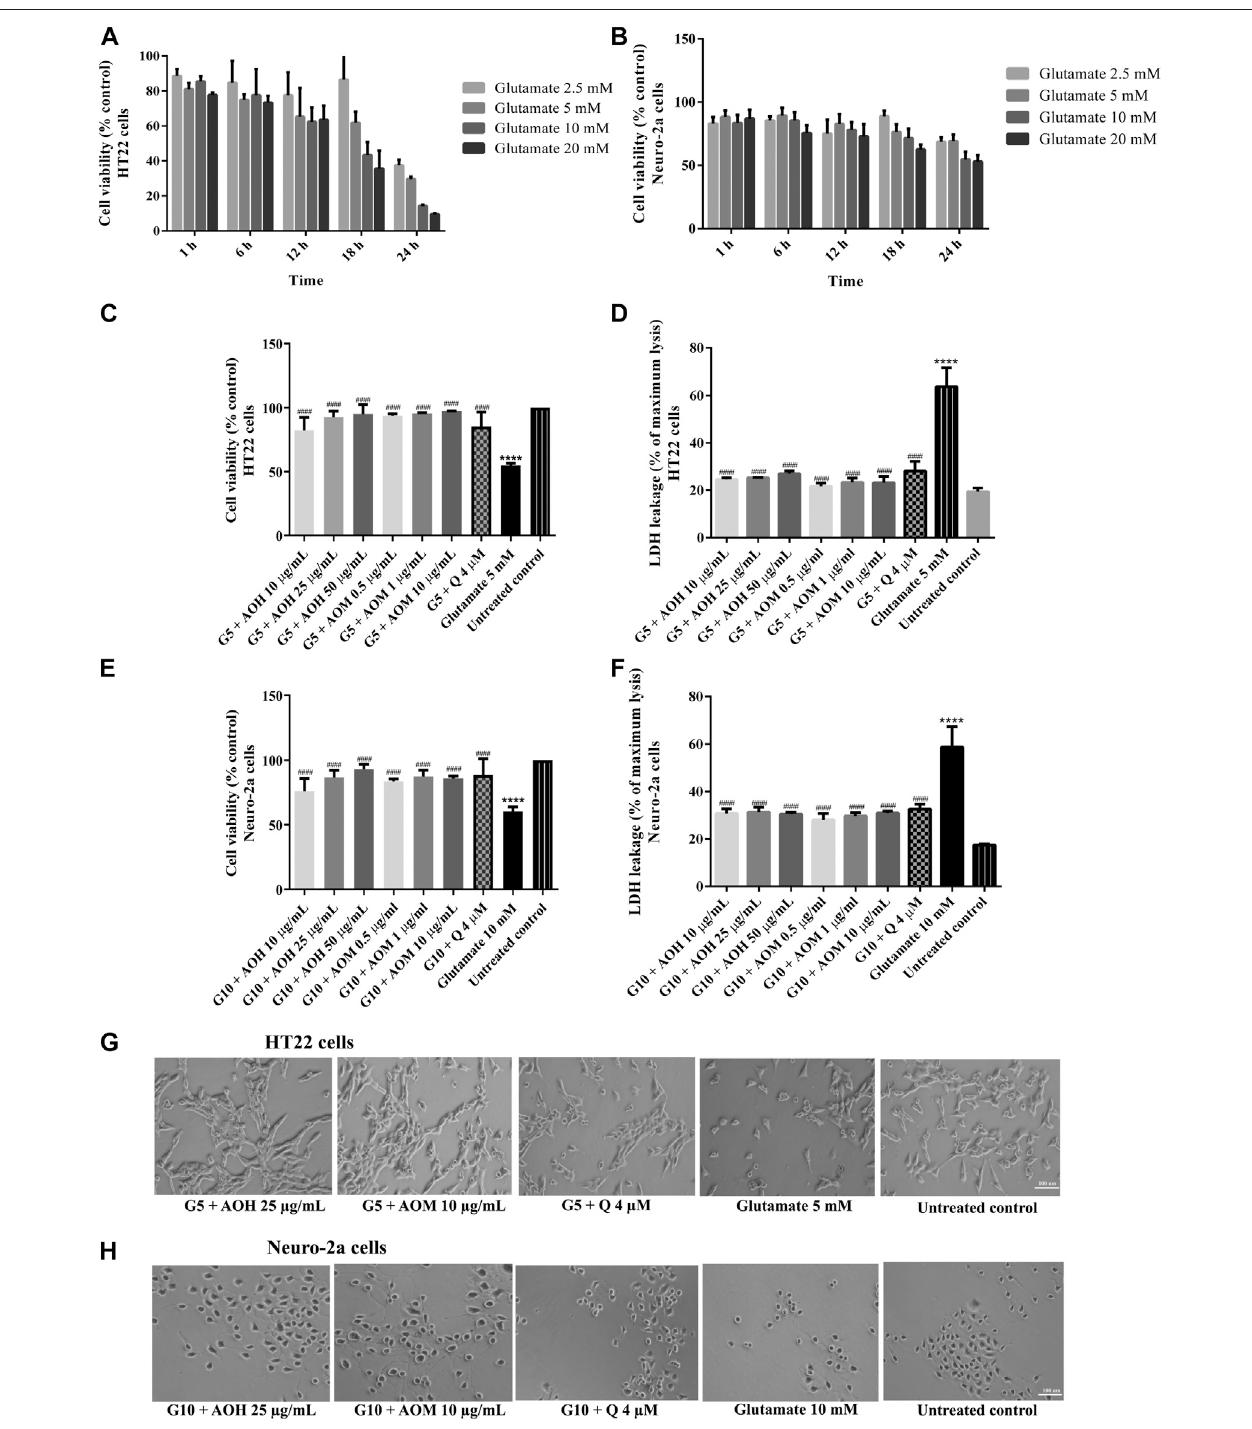
FIGURE4| ProtectiveeffectsofAOextractsonglutamate-inducedtoxicityinHT22andNeuro-2acells.Cellswereexposedtovariousconcentrationsofglutamate for different times in HT22 (A) and Neuro-2a cells, cell viability was measured by MTT assay (B) . Cell viability of HT22 (C,D) and Neuro-2a cells (E,F) , cell morphology of HT22 (G) andNeuro-2a (H) aftertreatmentwithdifferentconcentrationsofAOextracts. Cellmorphologywasobservedundermicroscopeat5 × magni fi cation. Samples were treated with AO extracts for 48 h and exposed to glutamate (G5: 5 mM glutamate, G10: 10 mM glutamate) for 18 h (HT22 cells) or 24 h (Neuro-2a cells) to induce toxicity. The results are expressed as the means ± SEM of independent experiments ( n (cid:1) 3). **** p < 0.0001 compared to the untreated control; # p < 0.05, ## p < 0.01, ### p < 0.001 and #### p < 0.0001, compared to the group exposed to glutamate only.